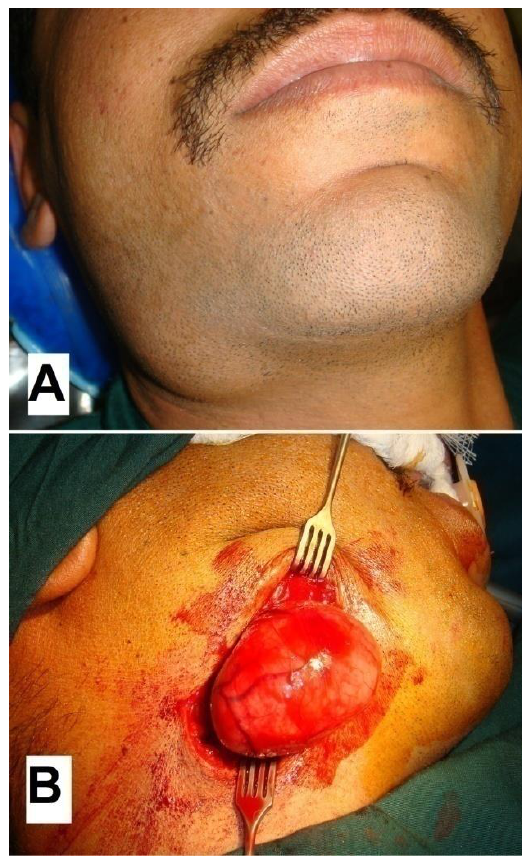
Figure 1: (A) Preoperative view showing enlarged right submandibular lymph node. (B) Intra-operative view showing excision of the enlarged lymph node through submandibular incision.